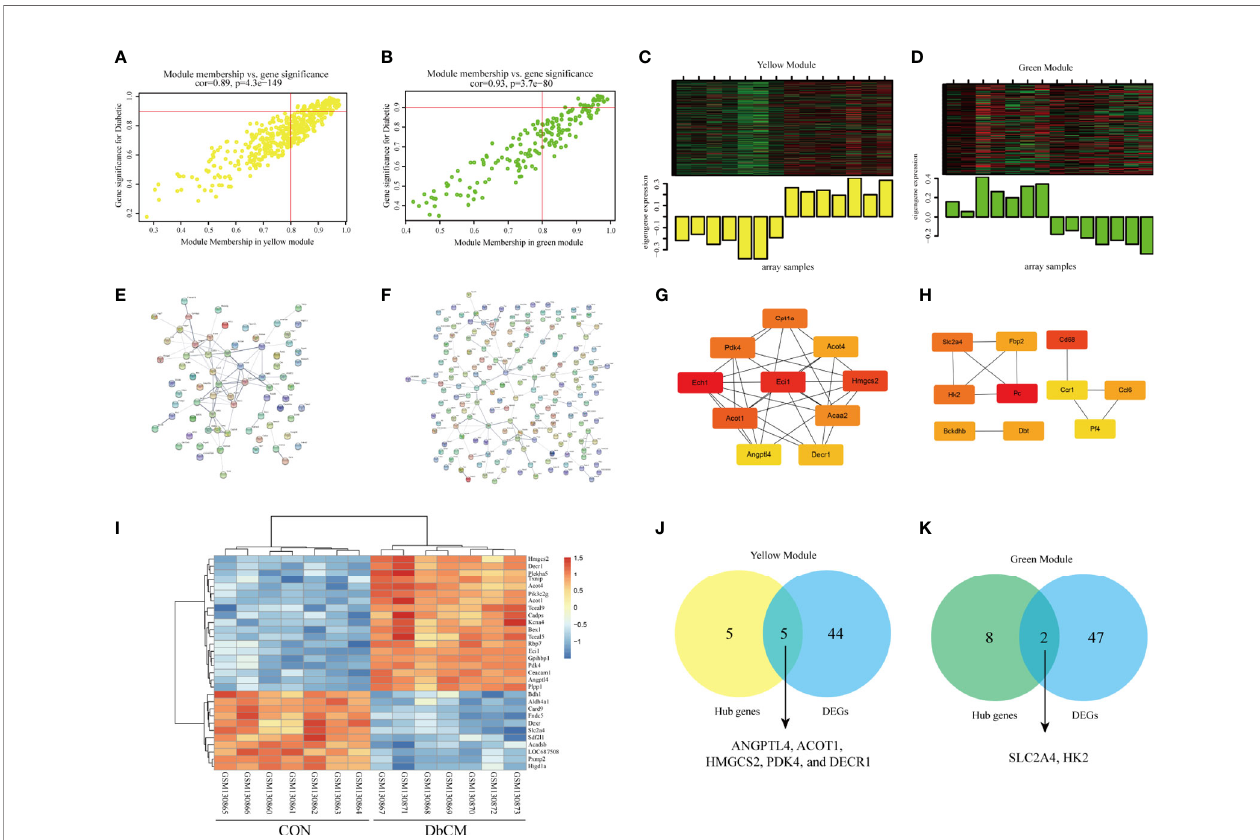
FIGURE 3 | Validation of real hub genes in yellow and green modules. (A, B) Scatter plot of module eigengenes in the yellow module and the green module. (C, D) The module heatmap and eigengene of array samples in the yellow module and the green module. (E, F) PPI network analysis of representative genes in the yellow module and the green module. (G) Top 10 hub genes in the yellow module selected by the “ cytoHubba ” plugin in the Cytoscape based on the MCC algorithm. (H) Top 10 hub genes in green model selected by the “ cytoHubba ” plugin in the Cytoscape based on MCC algorithm. (I) Heatmap of top 30 DEGs between normal and diabetic animals heart tissue. (J, K) Identi fi cation of the intersection between DEGs and the hub genes in the yellow module and the green module. DEG, differentially expressed gene; PPI, protein-protein interaction.